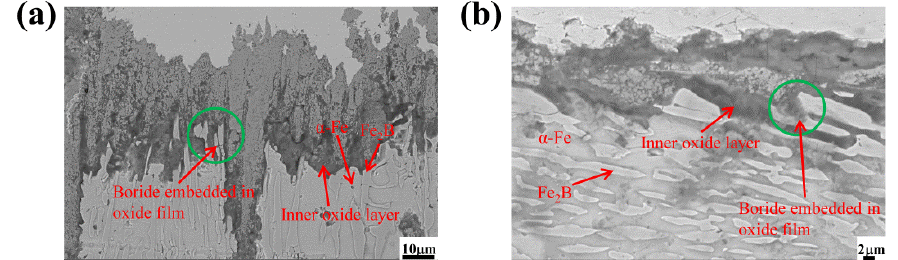
Figure 11. High-magnification SEM morphology of the A4 sample oxidized for 60 h at 1073 K: ( a ) Fe 2 B // sample, ( b ) Fe 2 B ⊥ sample.